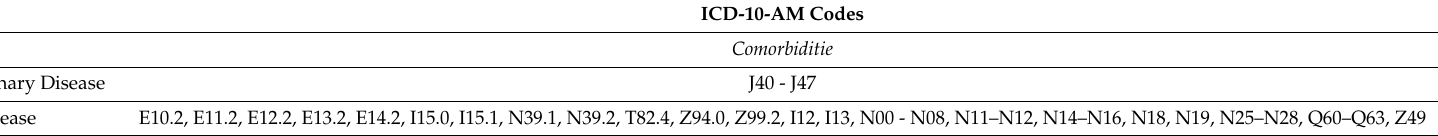
Table A2. ICD-10-AM codes for comorbidities of ARF and